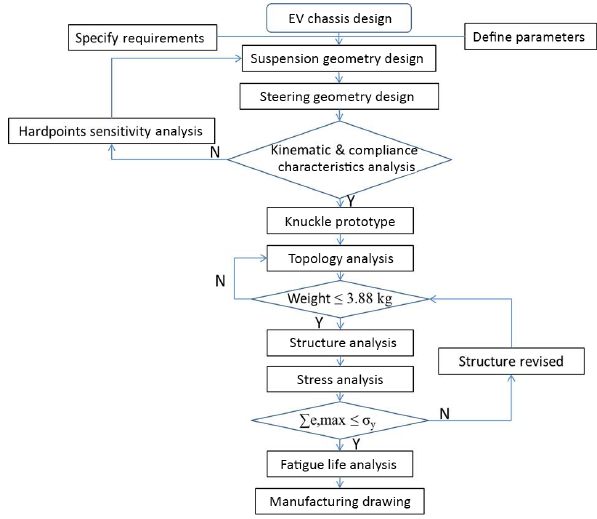
Figure 1. Design flow chart for lightweight design and analysis of steering